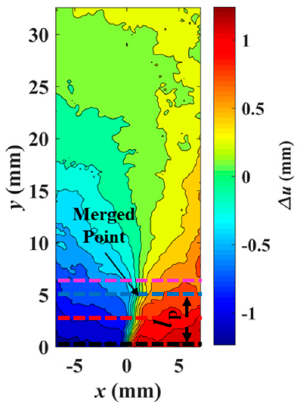
Figure 3. Incremental horizontal displacement contours of the dry sample.